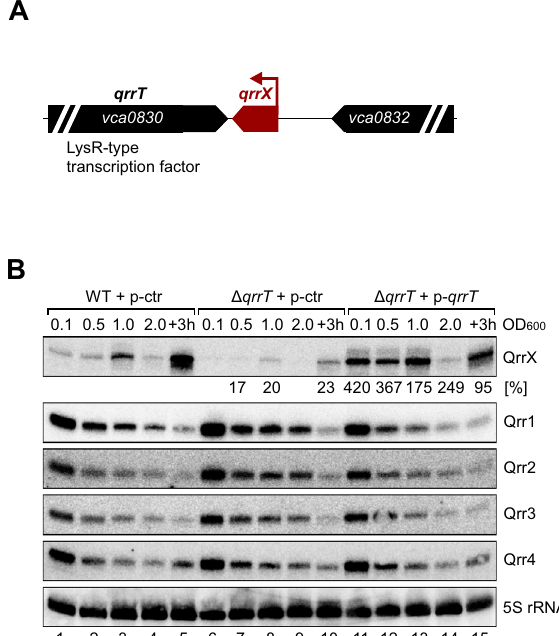
( PqrrX::mKate2 )oramutatedversion( PqrrX::mKate2 Δ P1or PqrrX::mKate2 Δ P2,see Fig. S7G) were cultivated in LB medium to OD600 of 1.0 and analyzed for fl uor- escence. V.cholerae wild-typecarrying PqrrX::mKate2 weresetto1.Barsshowmean of independentbiologicalreplicates±SD, n =3. D ChIP analysis of QrrT. V.cholerae wild-type and qrrT::3XFLAG cells were cultivated to OD600 of 1.0 and subjected to chromatin immunoprecipitation (ChIP). Bar graphs show relative levels of the qrrX and the vqmR promotors (P qrrX and P vqmR ), determined by quantitative PCR and P qrrX levels in WT V. cholerae were set to 1. Data are presented as mean values of independent biological replicates ±SD, n =3. Source Data underlying panels B – D are provided as a Source Data fi